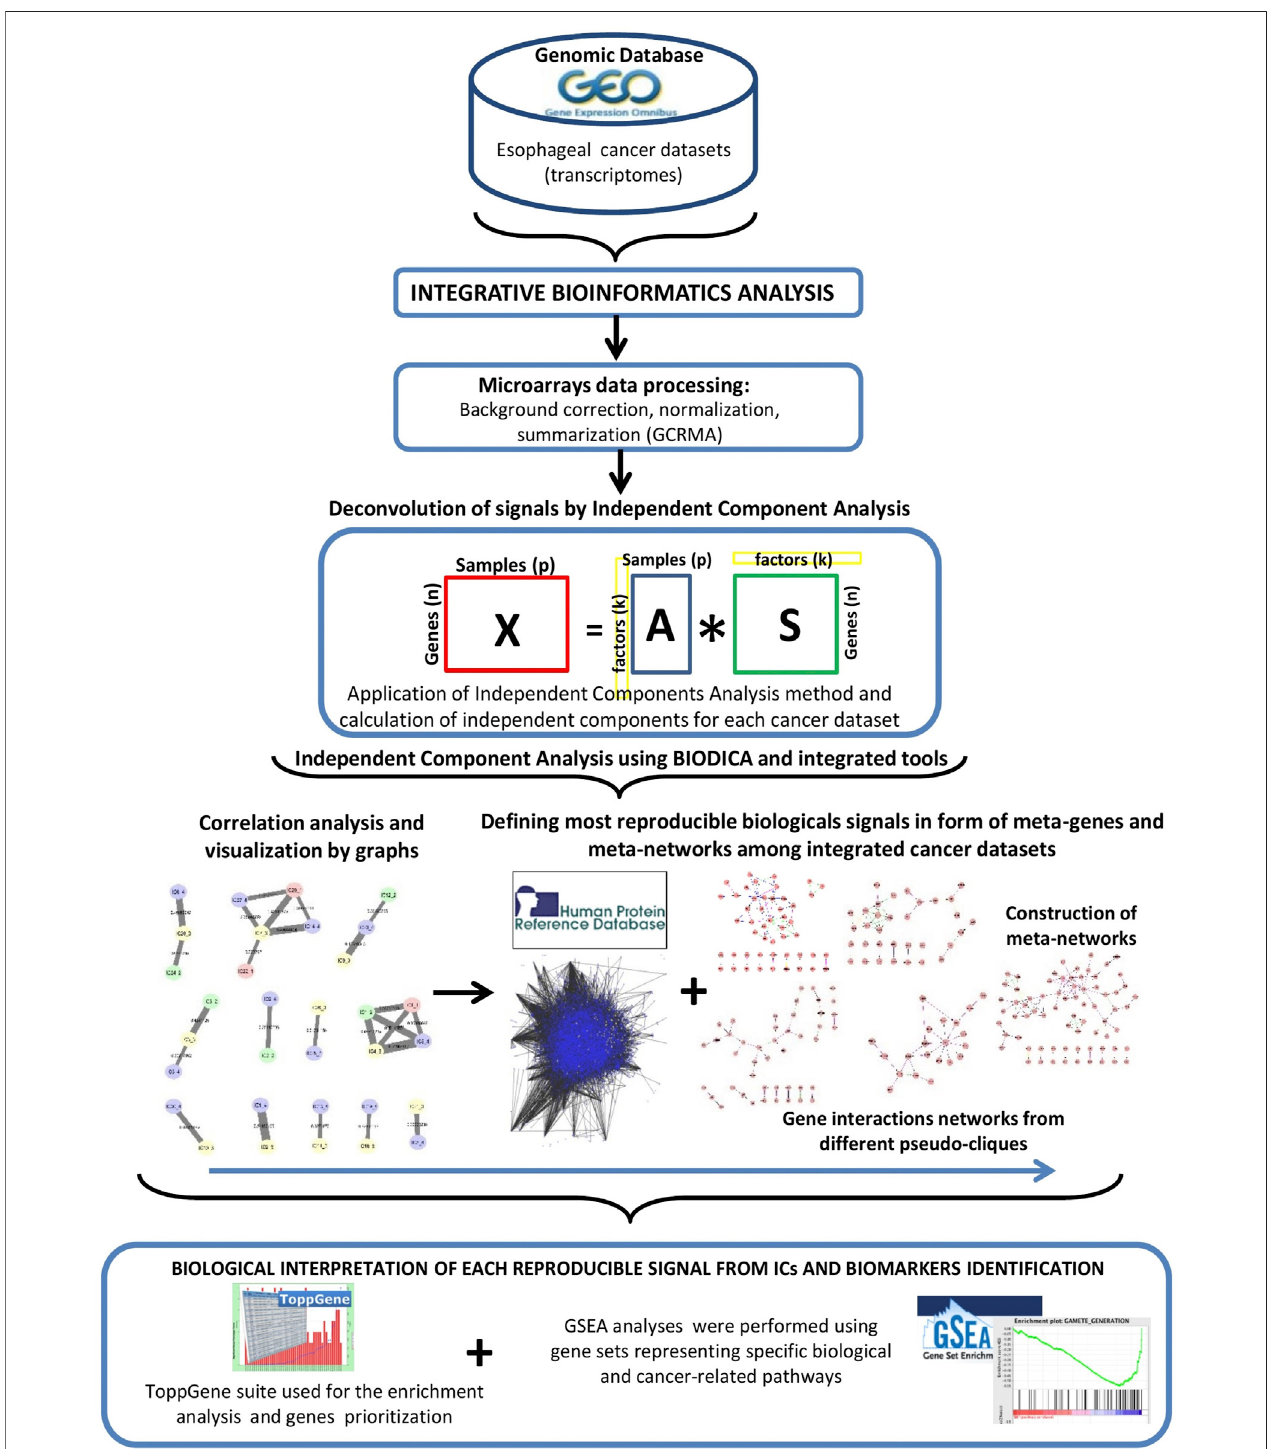
FIGURE 1 | Schematic representation of the methodology.